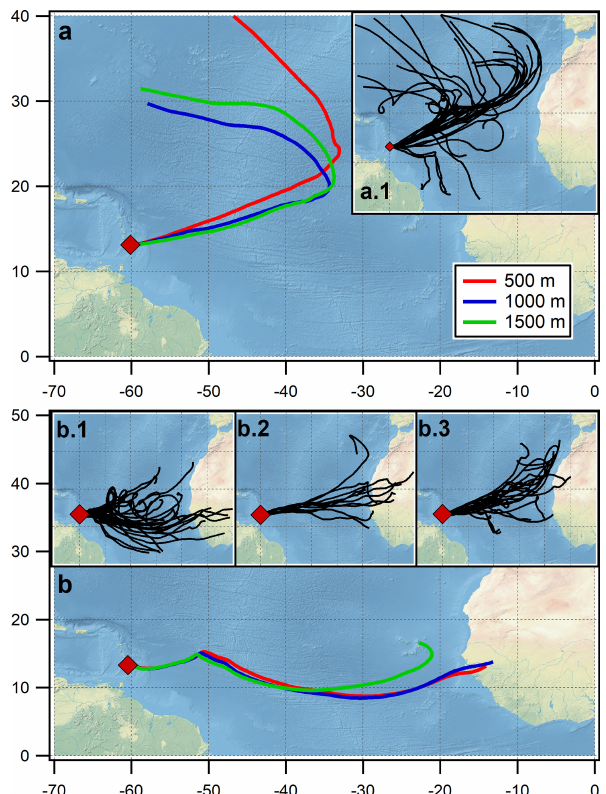
Figure 1. HYSPLIT back trajectories at Ragged Point, Barba- dos (red diamond), for the EUREC 4 A/ATOMIC field campaign. (a) Back trajectories for 8 February 2020 18:00UTC at heights of 500m (red), 1000m (blue), and 1500m (green) exemplify air mass origins under clean marine sampling conditions. Subplot (a.1) shows all back trajectories from clean marine sampling con- ditions collected at 6h intervals with a release altitude of 1000m